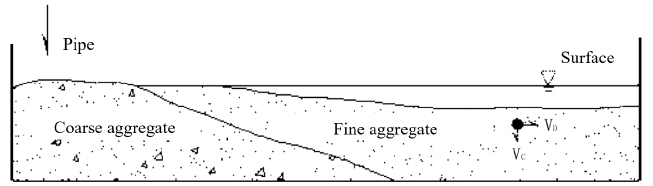
Figure 5. Sedimentation model of backfilling slurry with different aggregate